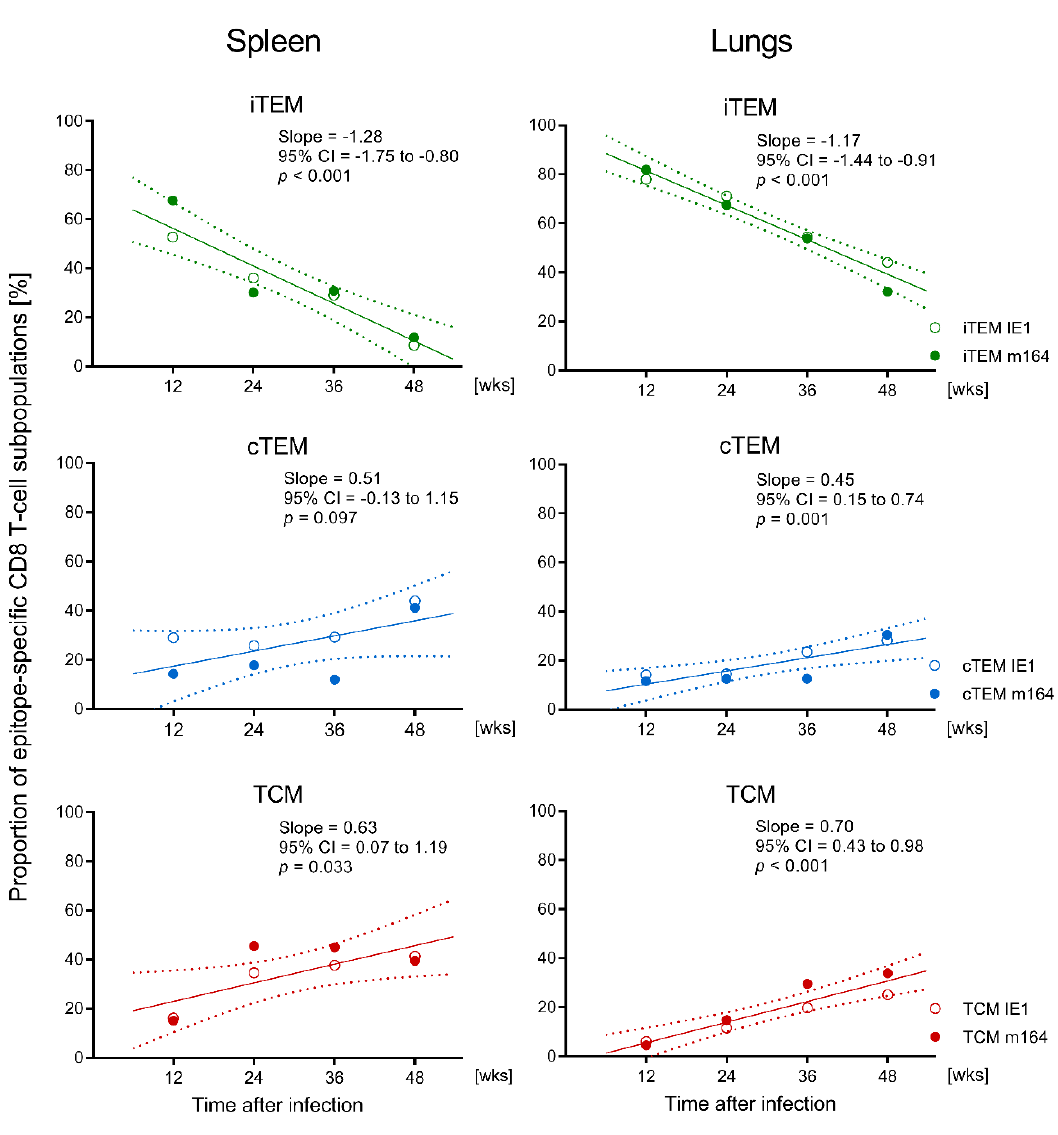
Figure 4. Trend analysis of CD8 T-cell memory population dynamics after intraplantar infection. Data from times during latent infection (wks 12, 24, 36, and 48) shown in Figure 2B (spleen) and Figure 3B (lungs) were subjected to linear regression analysis for determining the statistical significance of loss of iTEM (negative slope) and the corresponding rise of cTEM and TCM (positive slopes) over time. Dotted curves represent the 95% confidence intervals (CI). Trends are considered significantly different to the null hypothesis of no trend (slope 0) for p < 0.05.